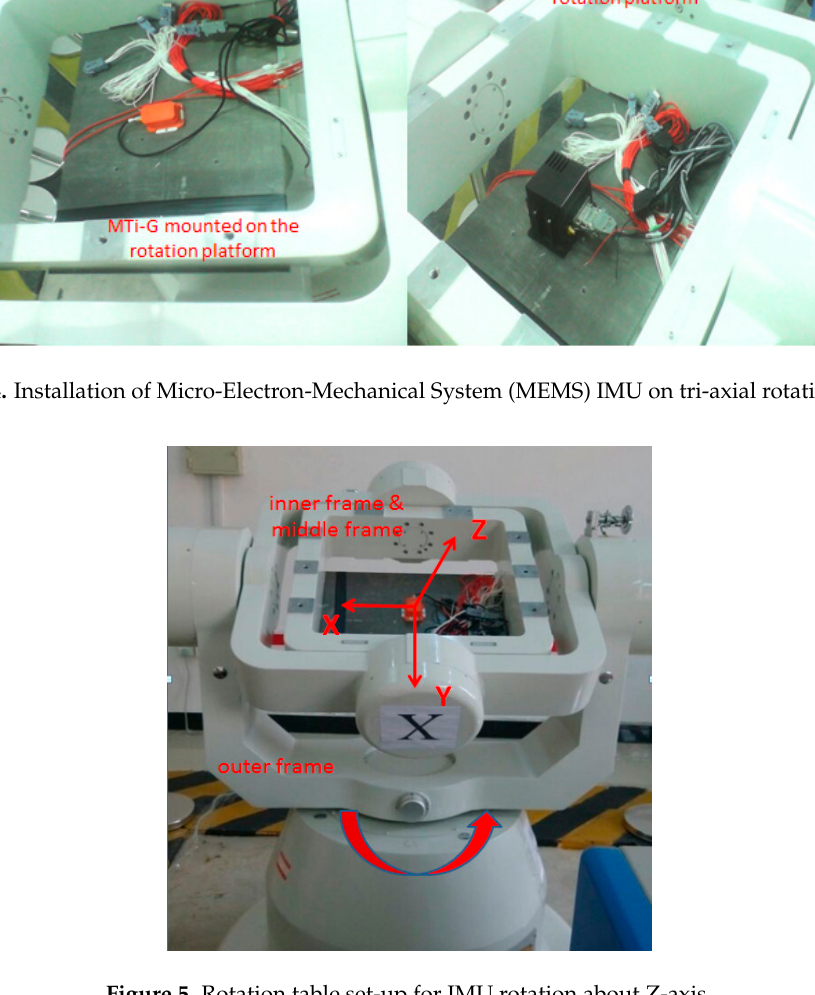
Figure 5. Rotation table set-up for IMU rotation about Z-axis.